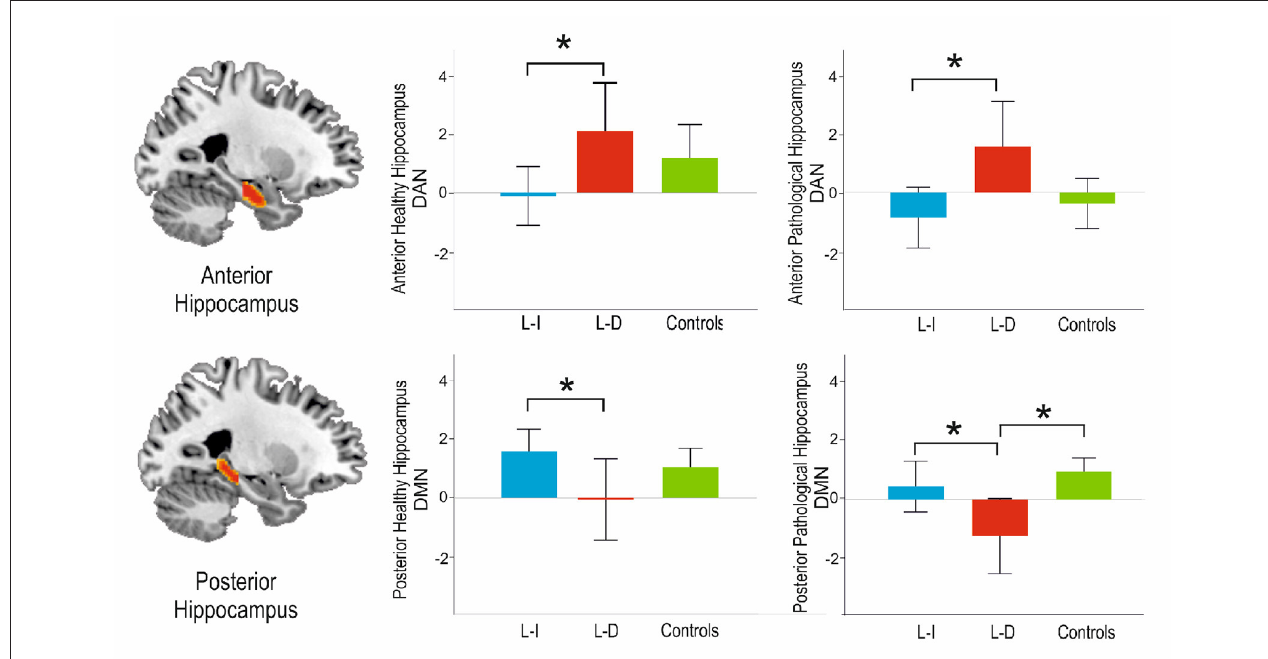
FIGURE 3 | Main results of the post-hoc analysis among groups connectivity analyses with the DAN and the DMN along the longitudinal axis of the hippocampus. L-I, Learning Intact; L-D, Learning Decline. *Indicates statistical significance p < 0.05.